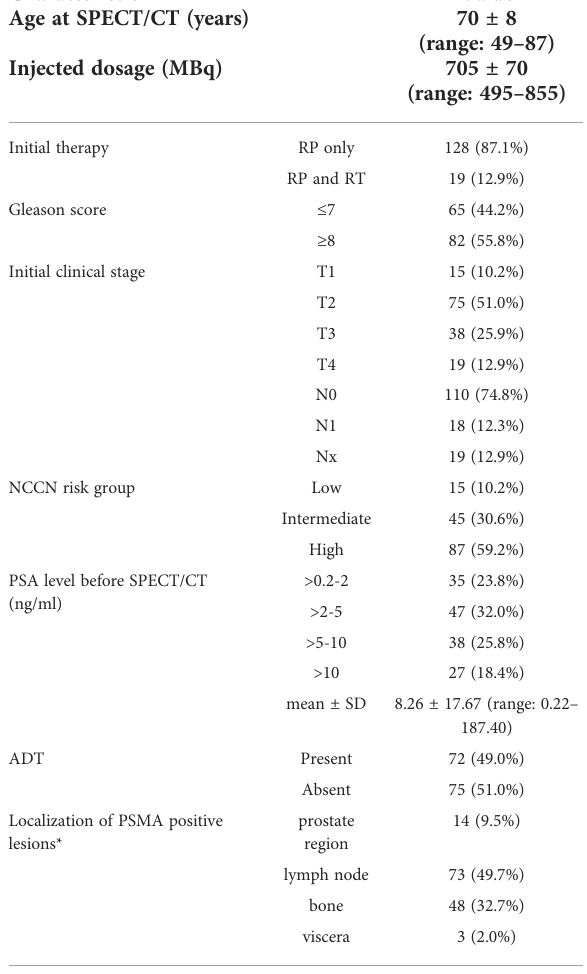
TABLE 1 Clinical characteristics of 147 patients.